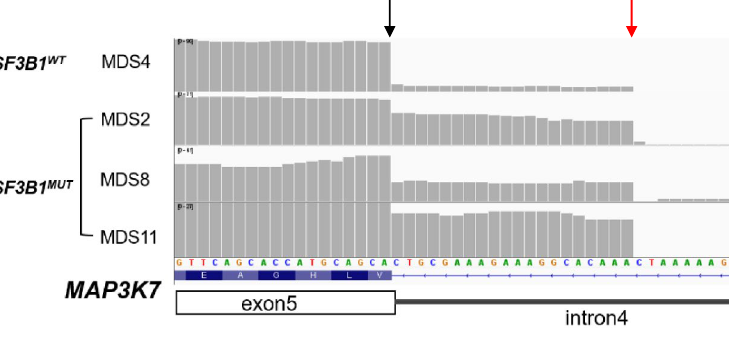
Figure 7. Analysis of MDS clinical samples. ( a ) RNA-seq analysis of ABCB7 and MAP3K7 expression levels in SF3B1 WT - or SF3B1 MUT -MDS patients diagnosed at Tohoku University Hospital; * p < 0.05. ( b , c ) Read-coverage visualized with IGV around canonical 3 ′ SS of ABCB7 exon 9 ( b) and of MAP3K7 exon 5 ( c ) in representative MDS patients diagnosed at Tohoku University Hospital. SF3B1 WT - or SF3B1 MUT -MDS-T refers to the RNA-seq data of MDS patients diagnosed at Tohoku University